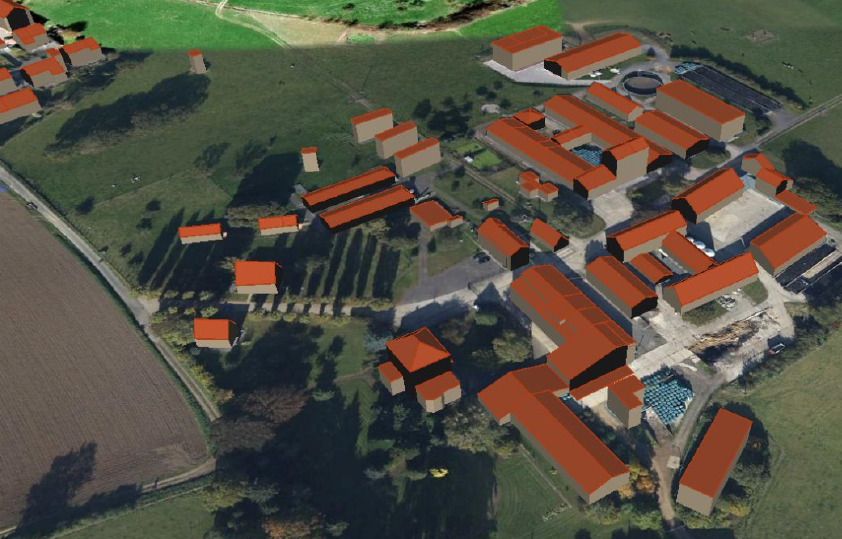
Figure 4: 3D City Model of the test area of Frankenforst in Vinxel/ Germany.